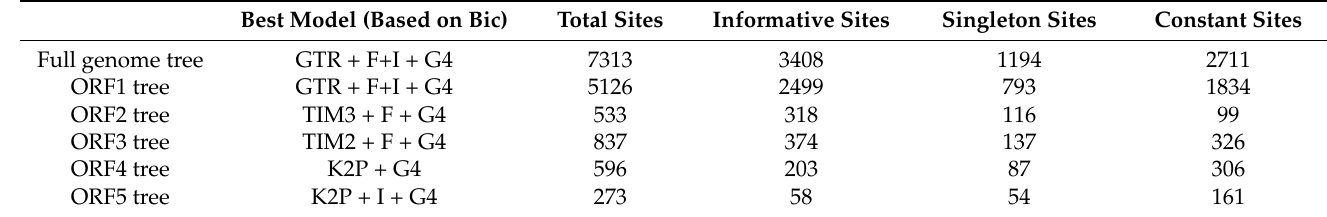
Table 2. Characterization of the phylogenetic trees using